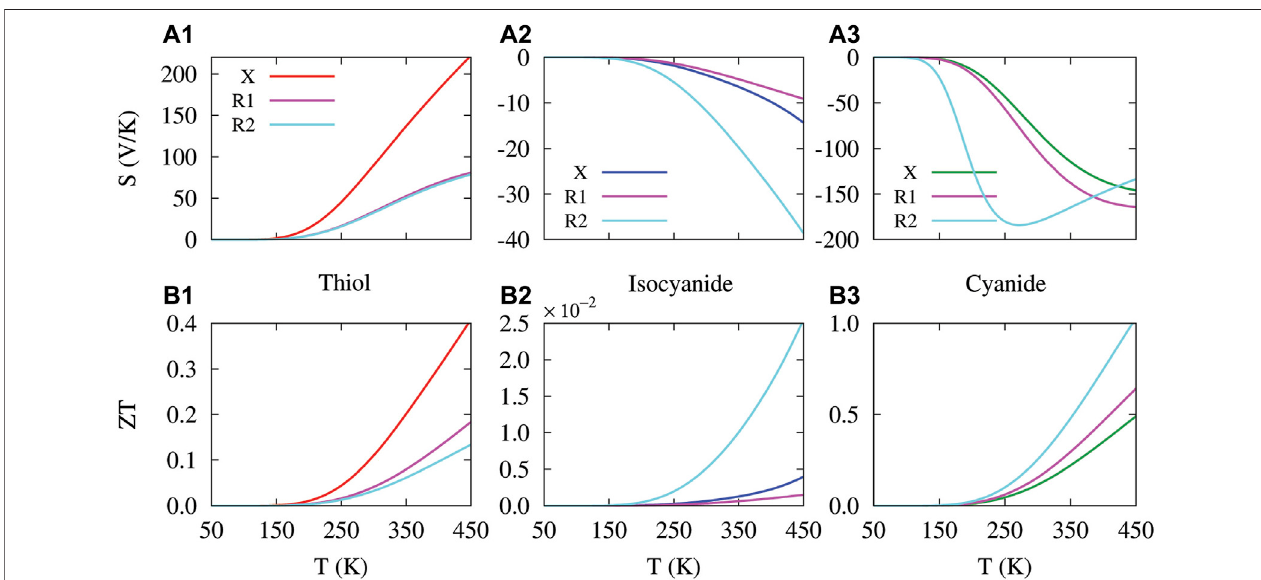
FIGURE6| Temperature dependencyofthethermopower (A1-A3) and fi gureofmerit (B1-B3) inthemolecularjunctionperturbed withtheaminesidegroupinR1 andR2positions.ThemoleculewasconnectedtotheAuelectrodesviathiol( fi rstcolumn),isocyanide(secondcolumn)andcyanide(thirdcolumn)anchoringgroups.The thermopower and fi gure of merit of the unperturbed molecular junction (labeled X) are depicted as a reference.